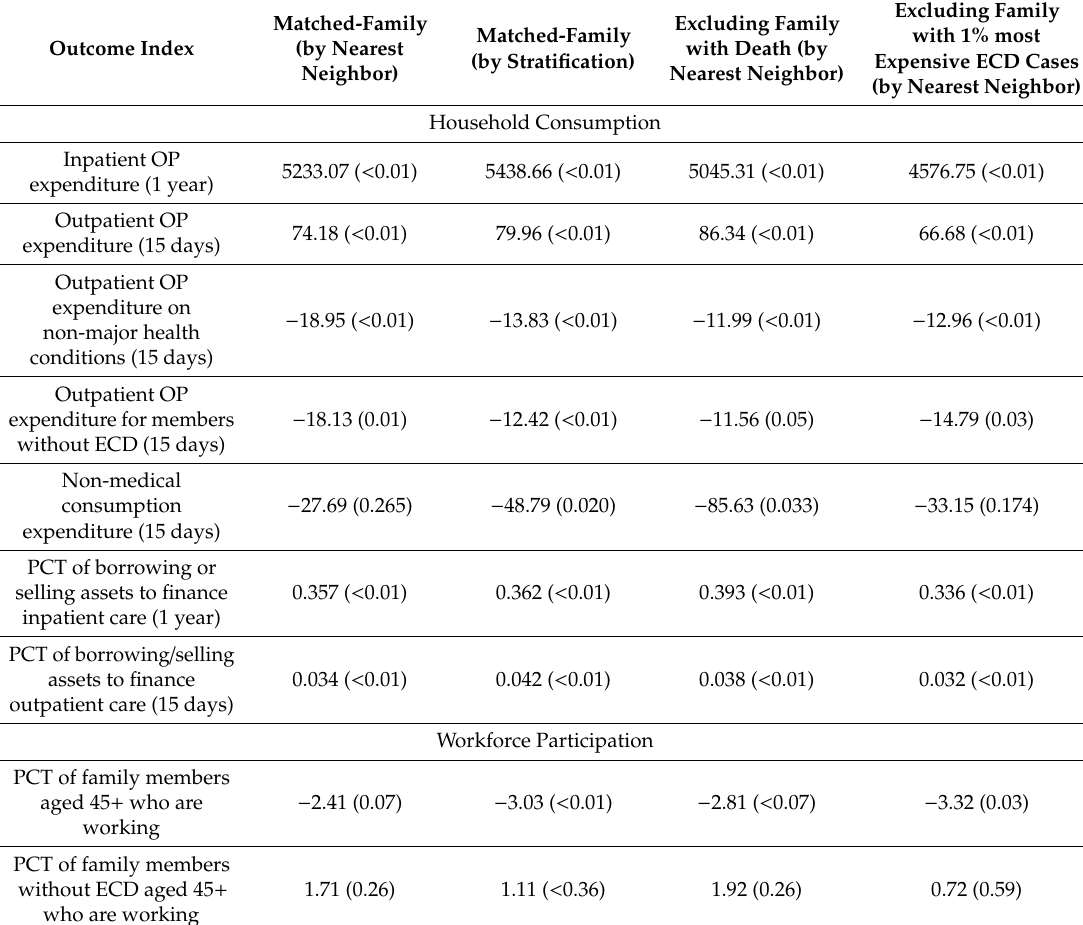
Table 4. E ff ects of ECD on family consumption and workforce participation in China. (Unit: CNY per family